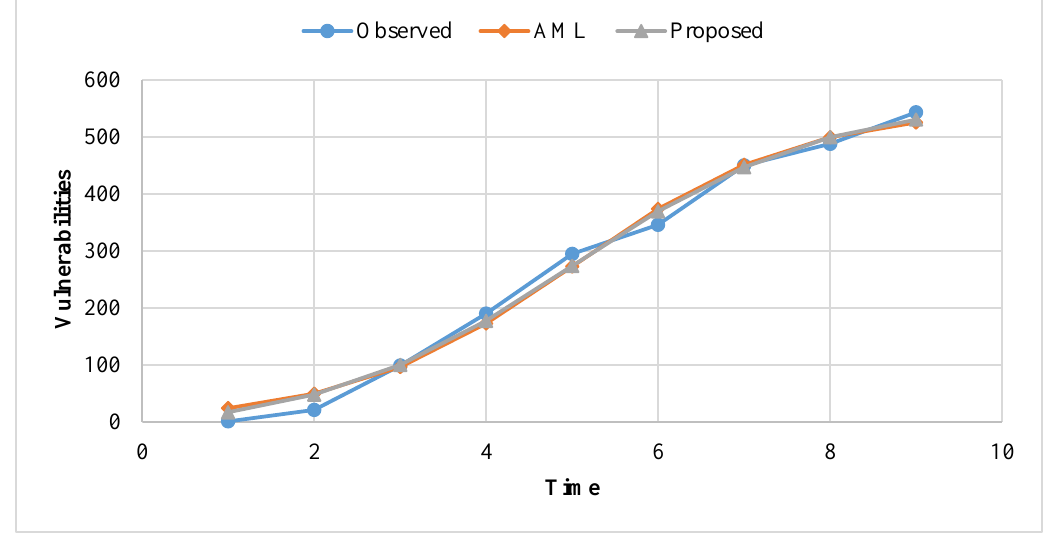
Fig. 4. Goodness of fit curve (Windows Server 2008)